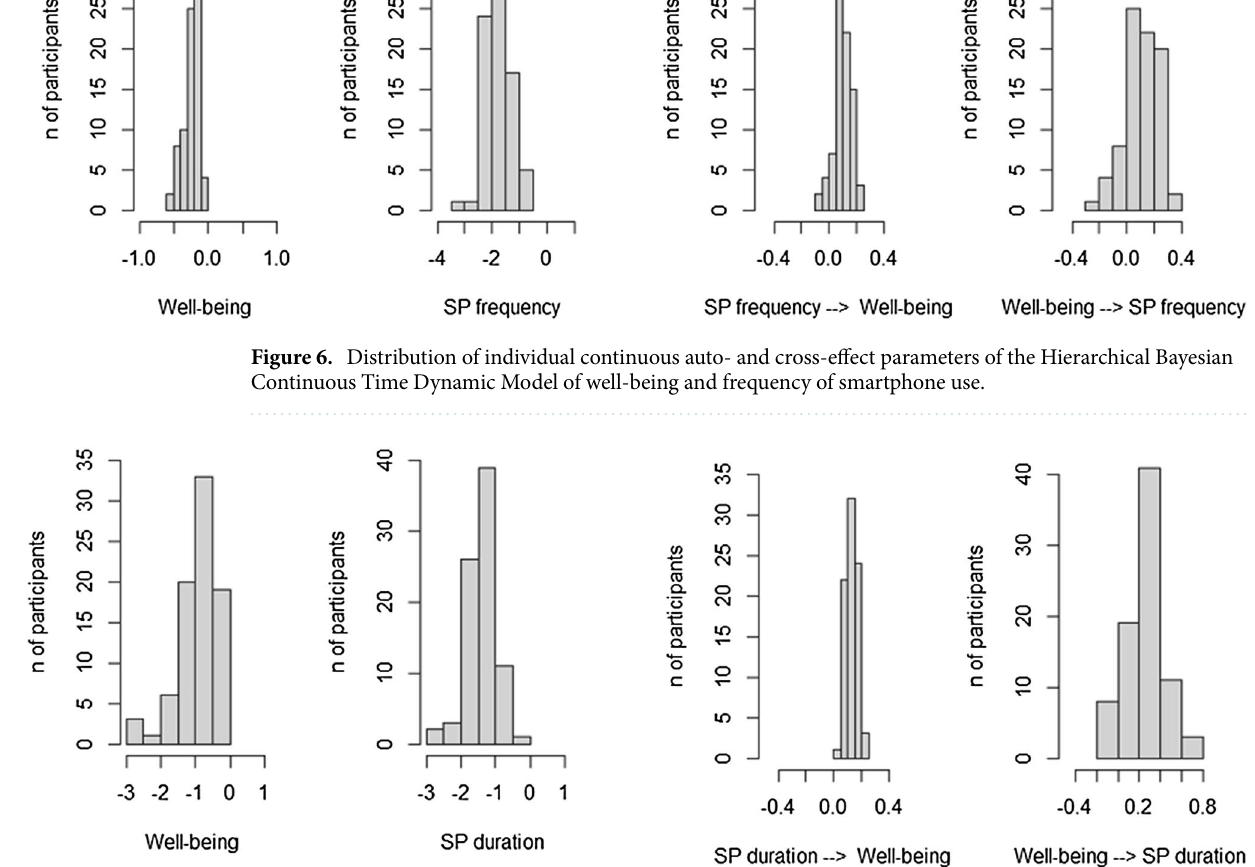
Figure 7. Distribution of individual continuous auto-and cross-effect parameters of the Hierarchical Bayesian Continuous Time Dynamic Model of well-being and duration of smartphone